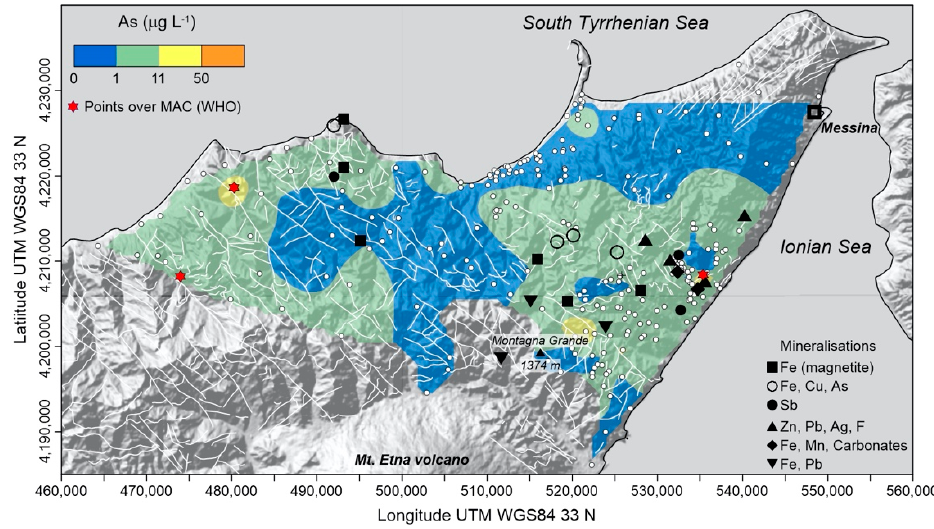
Figure 5. Concentration distribution map of As, reporting locations of sampling points (with indication of those exceeding the related MACs) and main mineral deposits; tectonic lineaments (white lines) are also illustrated.